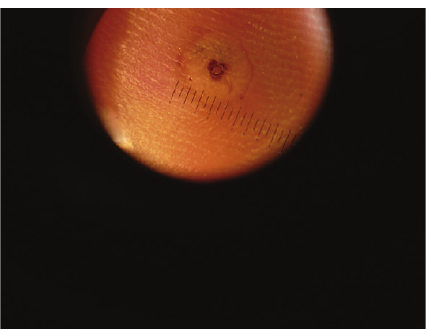
Figure 2: Dermoscopy findings in our patient. A black area with a plugged opening in the center surrounded by a whitish halo and by a peripheral slight reddening (surrounding inflammatory zone).